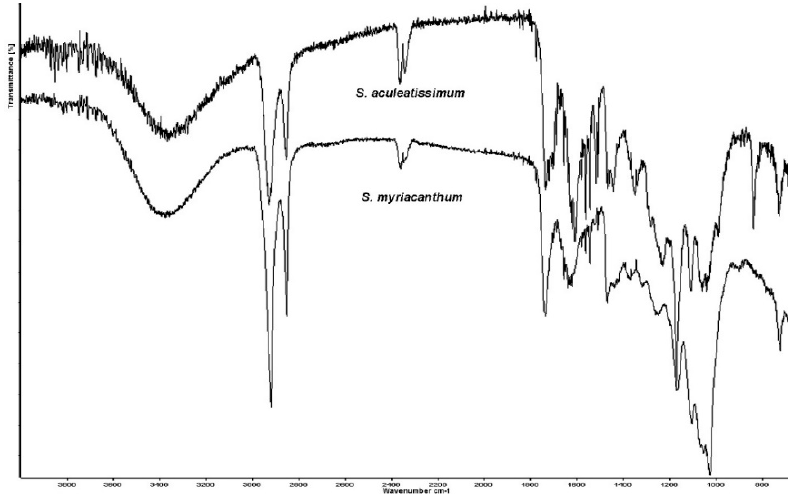
Figure 4. Attenuated Total Reflectance Fourier transform infrared spectroscopy (ATR-FTIR) spectra of S. aculeatissimum and S. myriacanthum .